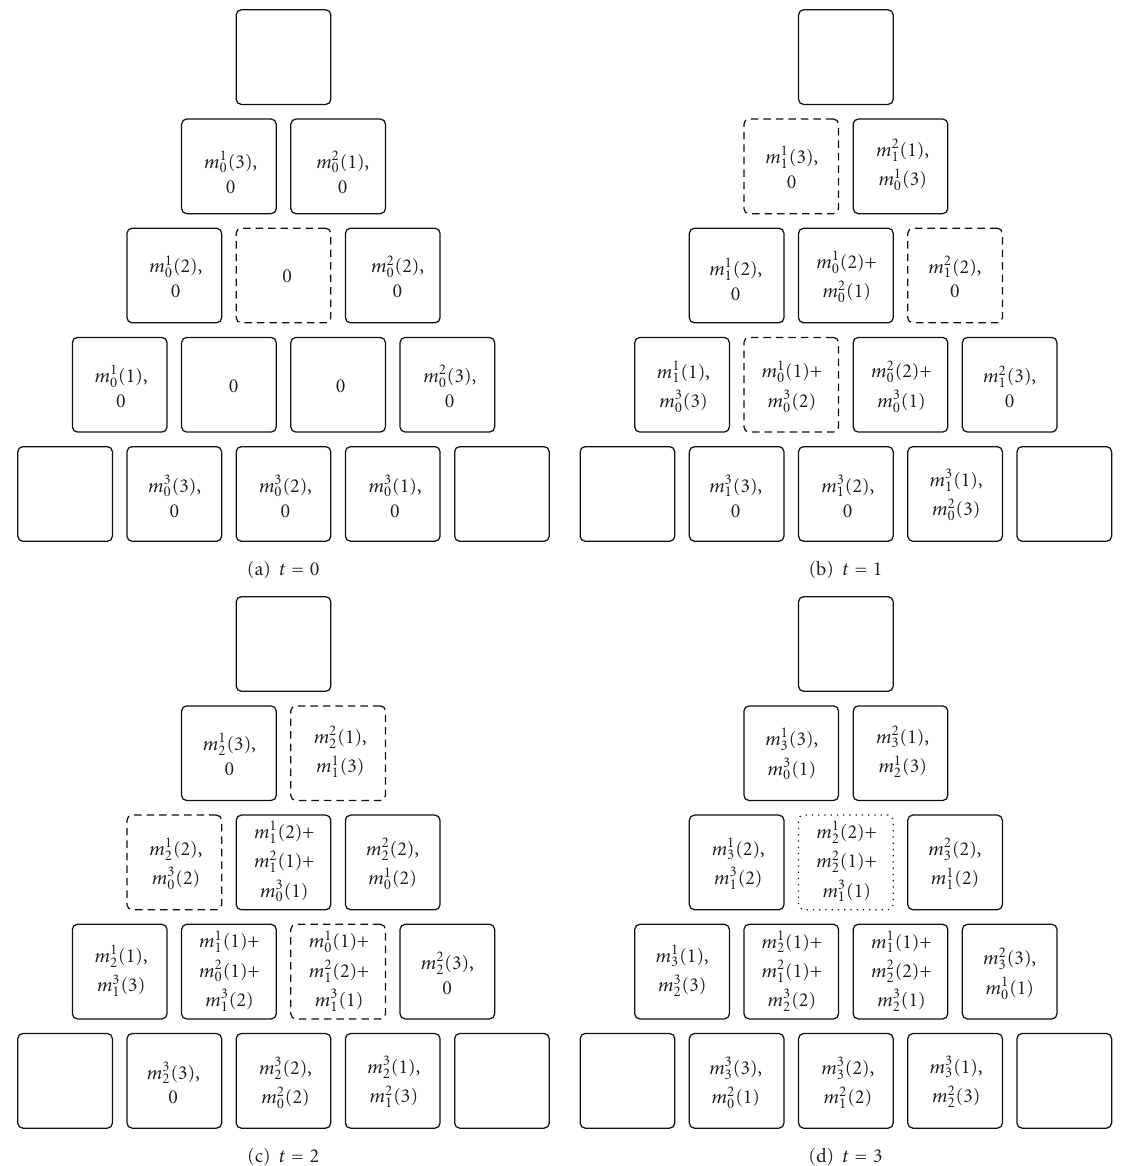
Figure 5: Example operation of the network code of Section 4, with K = 4. The transmissions of all nodes in the time slots 0, ... ,3 are depicted. Di ff erent transmissions by the same node are separated by a comma. Note, that the symbol transmitted at t = 3 by the node with dotted border can be obtained by summing all transmissions from nodes with a dashed border in earlier time slots. All nodes in the interior of the network perform this simple coding